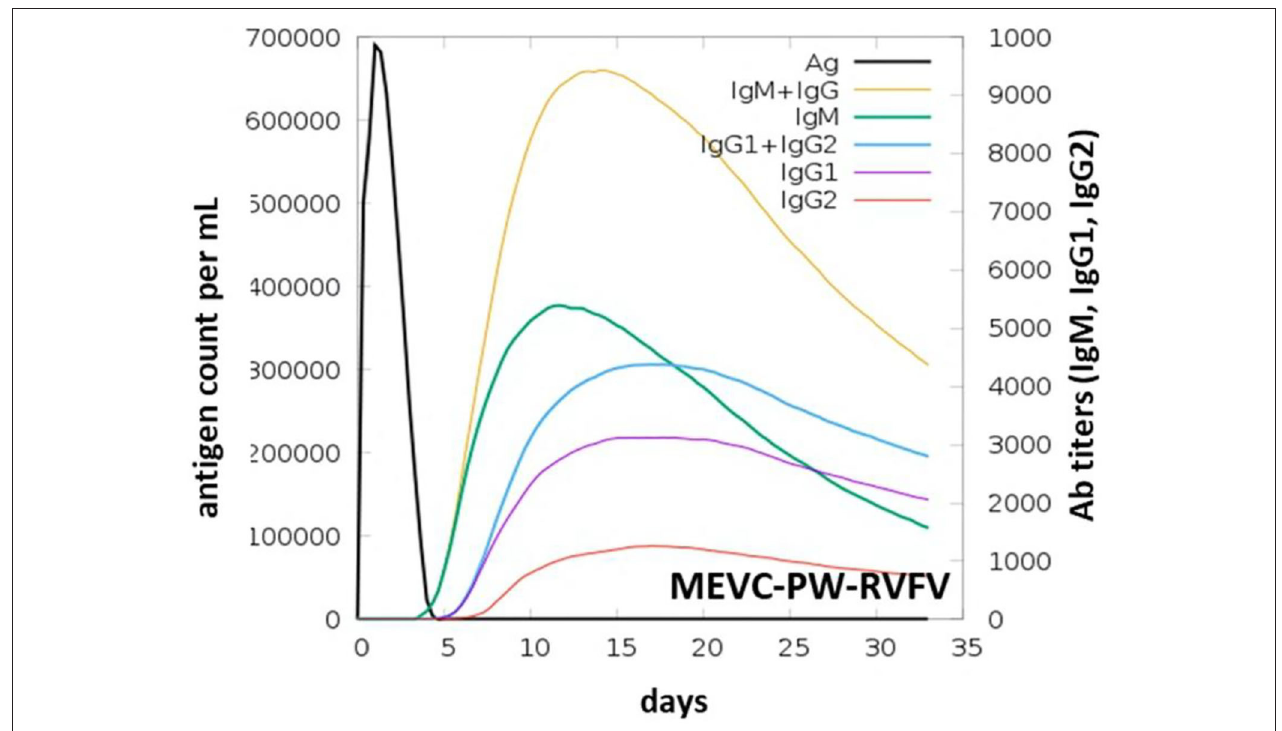
FIGURE 6 | Graph-based representation of induced immune response in the form of Ab titers observed through an immune-simulation graph of MEVC designed against the whole proteome of